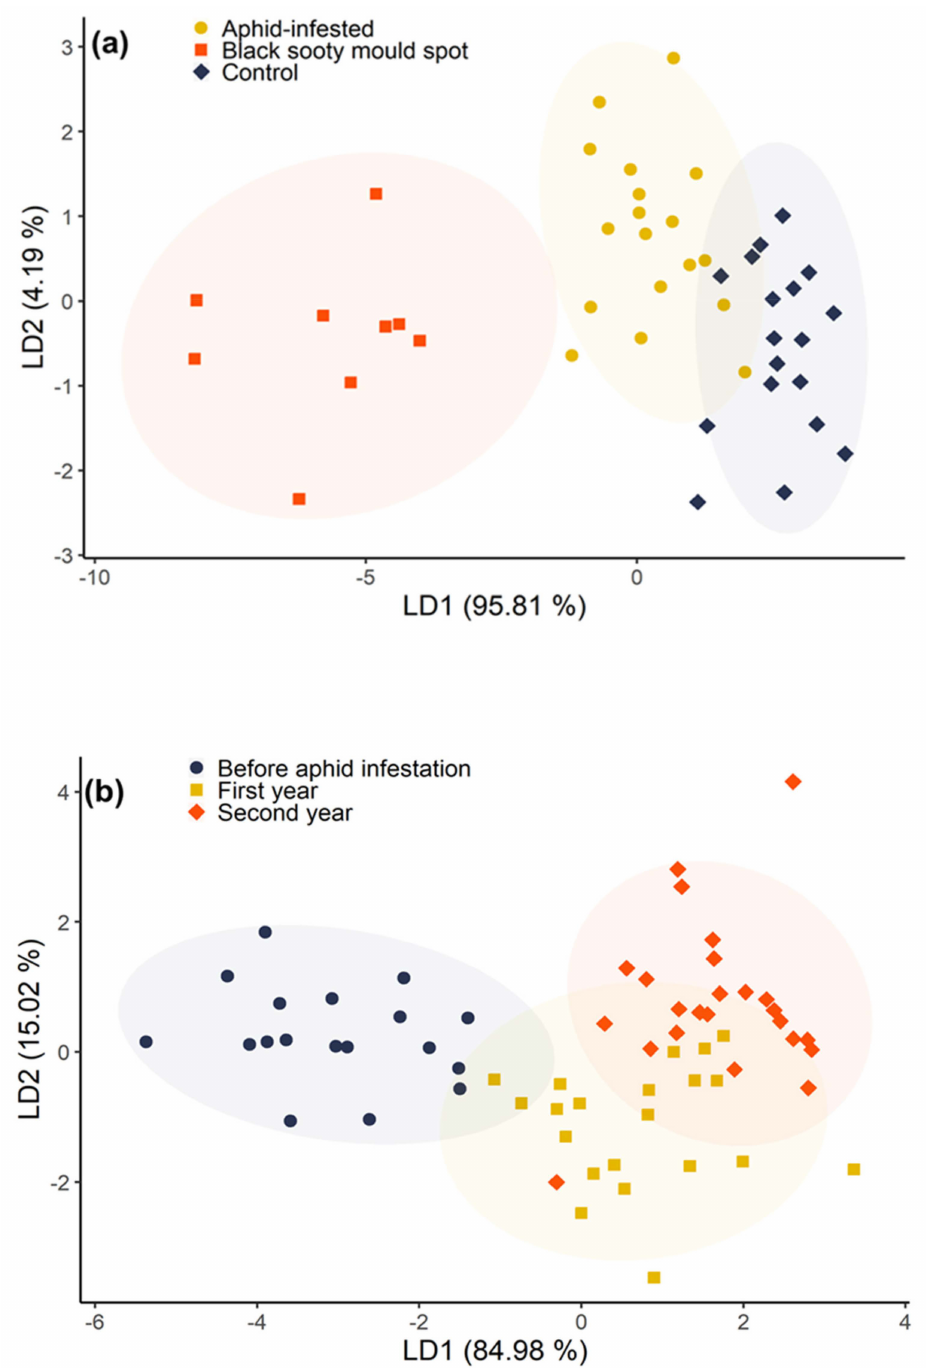
Figure 7. PCA-LDA bi-plots of the soil biochemical variables, classified ( a ) by treatment, and ( b ) by sampling time. A PCA was run to reduce the dimensions, followed by LDA to separate the treatments and sampling times. The variables were scaled and centred prior to the analysis. The shaded ellipses represent the 95% confidence